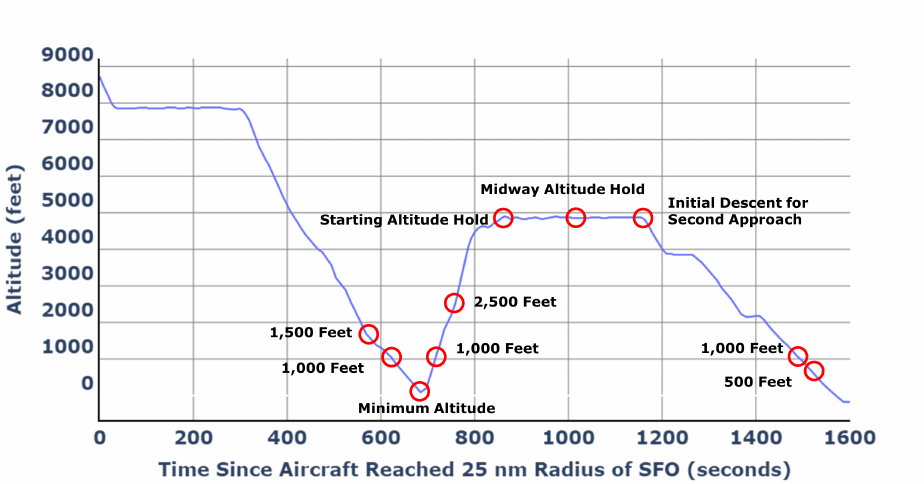
Figure 2. Summary of the significant points selected and their location during a typical go- around